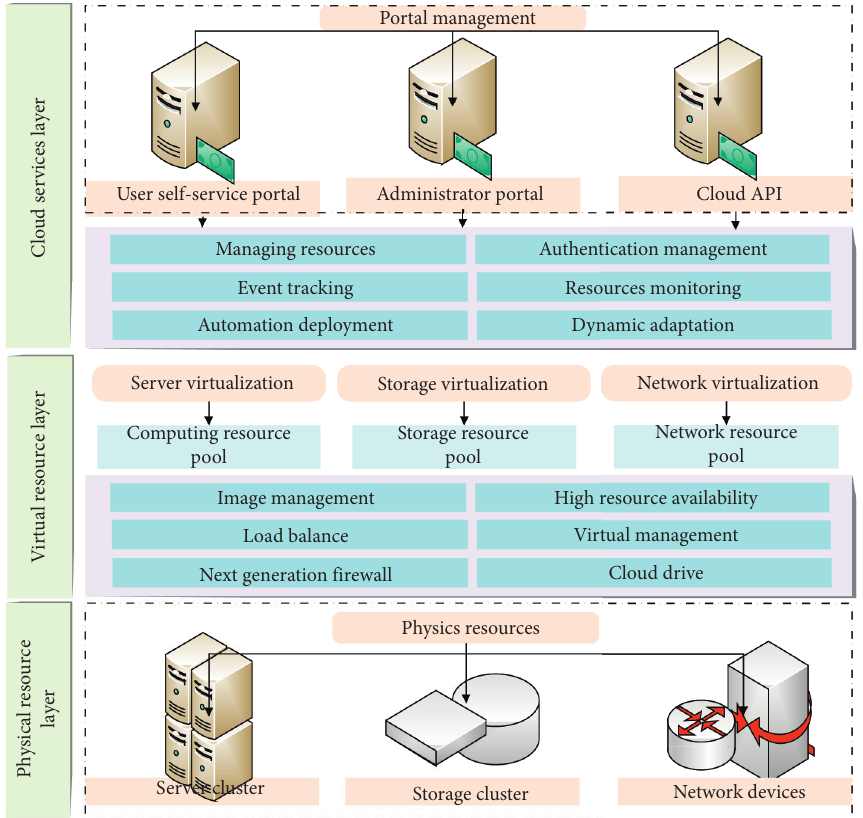
Figure 2: Transaction business process of e-commerce system based on big